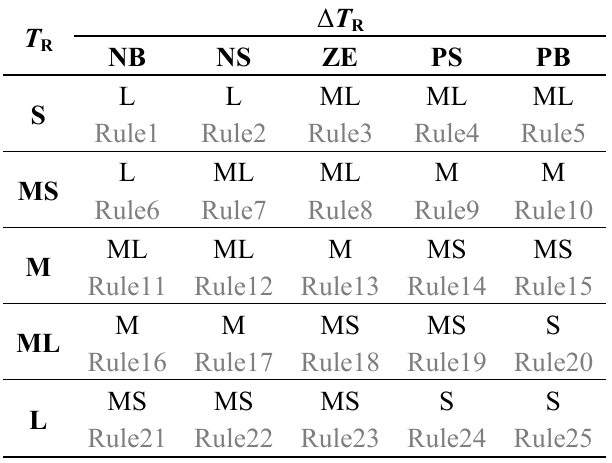
Table 1. Complete rule base for the proposed